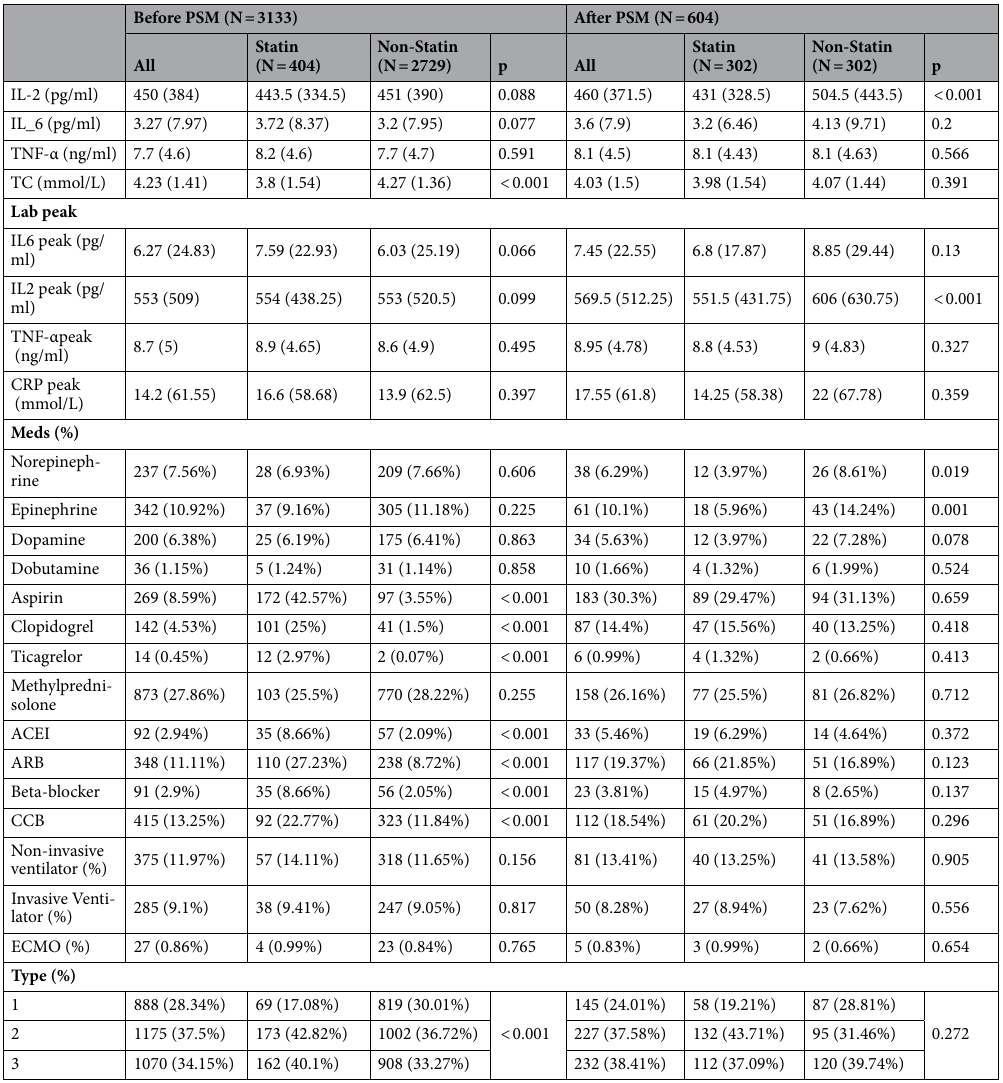
Table 1. Baseline characteristics of the study population by statin use before and after PSM. PSM, propensity score match; CHD, coronary vascular disease; BNP, serum B-type natriuretic peptide; TNI, Troponin I; ALT, Alanine Aminotransferase; AST, Aspartate transaminase; Cr, Creatinine; ALB, Albumin; LDH, Lactate dehydrogenase; WBC, White blood cell; Lymph, Lymphocyte; Plt, Platelet; CRP, C Reactive Protein; IL-2, Interleukin 2; IL-6, Interleukin 6; TNF-α, P.C.T., Procalcitonin; Tumor necrosis factor-α; APTT, activated partial thromboplastin time; INR, international normalized ratio; TC, Total Cholesterol; ACEI, Angiotensin- converting-enzyme inhibitors; ARB, angiotensin receptor blockers; CCB, Calcium Channel Blocker; ECMO, Extracorporeal membrane oxygenation. Continuous variables are presented as median (IQR), categorical variables are presented as n percentage.